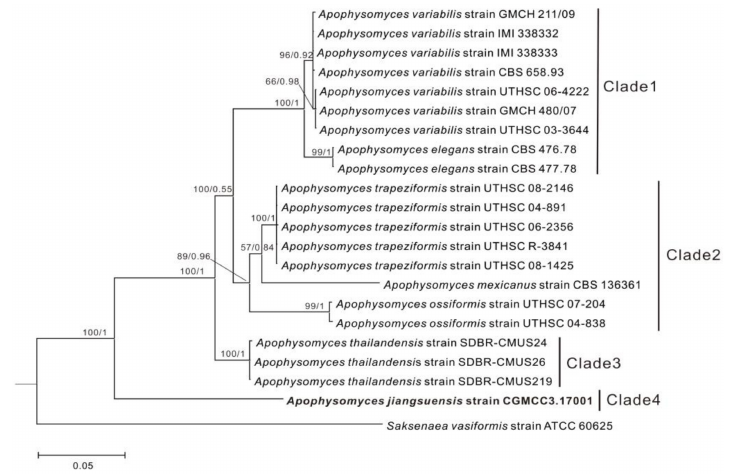
Figure 1. Phylogenetic tree derived from Bayesian inference (BI) and maximum likelihood (ML) analysis of a combined ITS and 28S rDNA sequences. Saksenaea vasiformis was used as an outgroup. Gene sequences (from holotype): KF048102 (ITS), KF055451 (28s rDNA). Diagnosis: Di ff ers from other Apophysomyces species in having spherical rather than pyriform